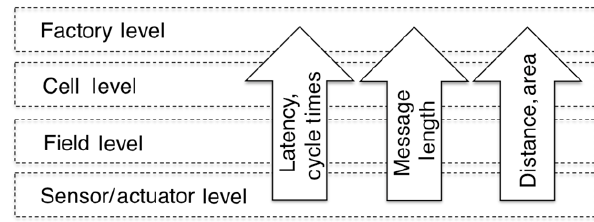
Figure 1. Classic multi-level organization of an industrial commu- nication system for automation applications.